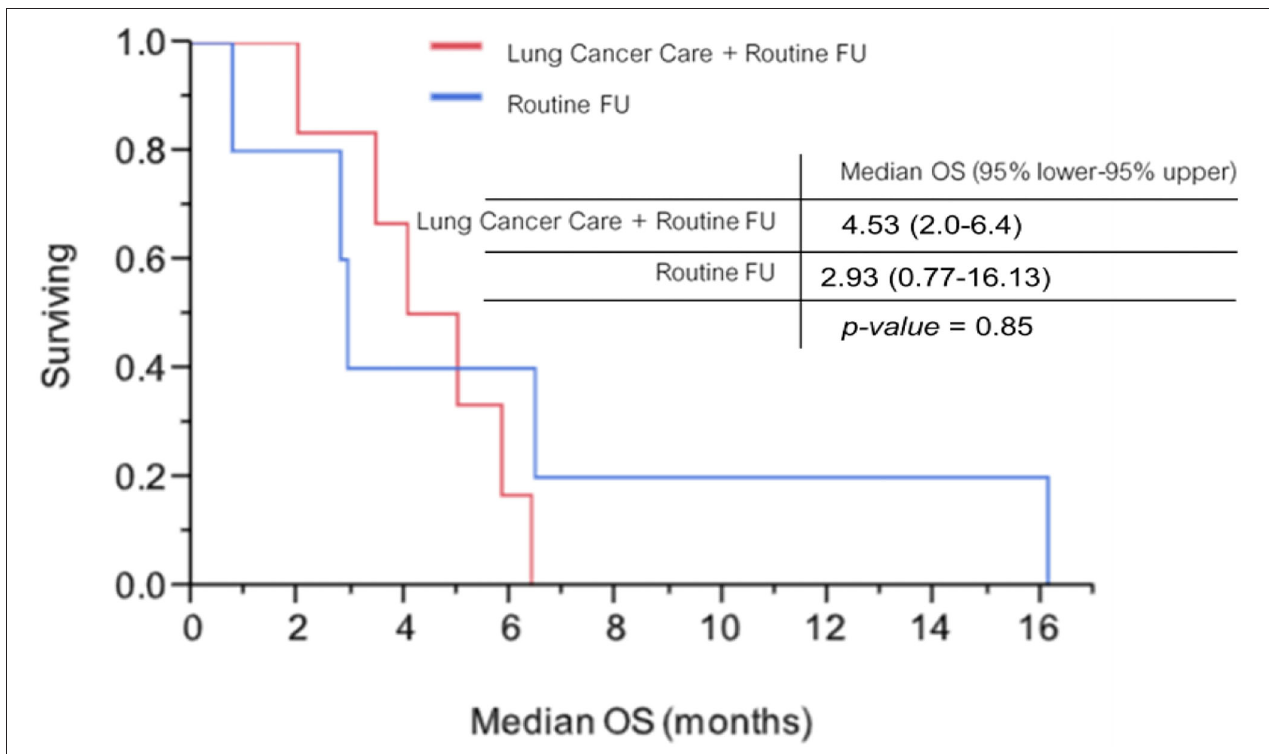
FIGURE 6 | Overall survival compared between the two arms using Kaplan-Meier analysis.